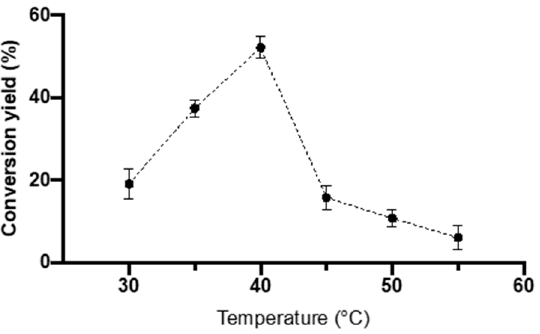
Figure 4. Effect of temperature (°C) on the esterification yield of the IBU-sorbitol ester. Reaction time: 15h (equilibrium condition). All measurements were performed in triplicate.